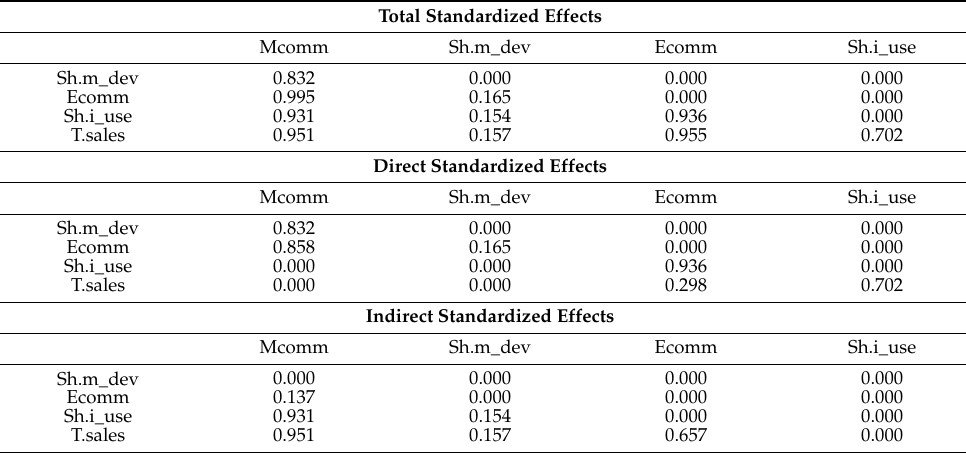
Figure 4. Diagram of relationships in SEM concerning m-commerce. Source: developed using AMOS for SPSS v20.